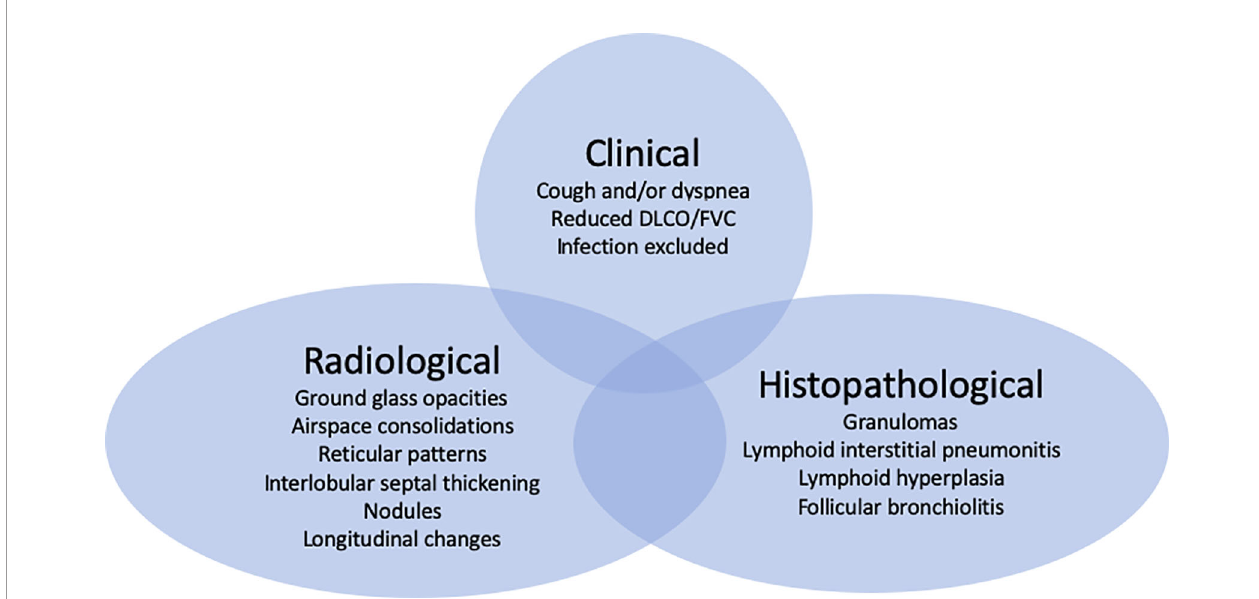
FIGURE 1 | (GL) ILD in CVID is characterized by clinical, radiological and histopathological features with patients presenting all or some of these manifestations. Which criteria to include for the diagnosis demands an imminent debate